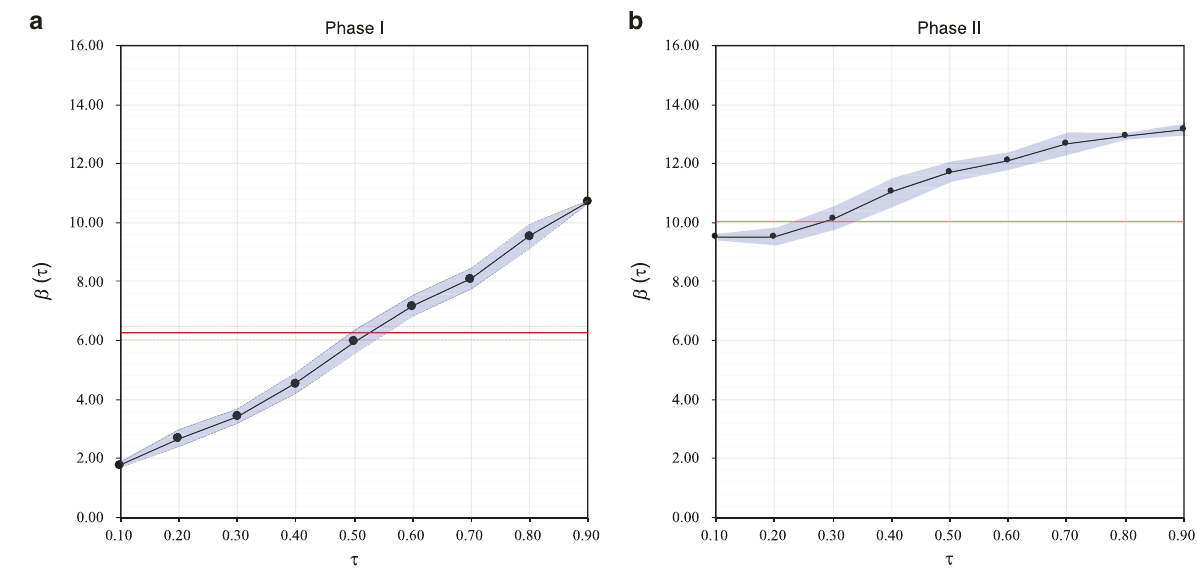
Fig. 2 The estimated results of the linear quantile regression model based on the of the fi rm-level trading data. In the plots of Phases I ( a ) and II ( b ), the estimated slopes of quantile 0.1 to 0.9 are plotted as a function of β ( τ ), the estimated intercepts of the results are not reported for simplicity and speci fi city reasons. The area enclosed by gray dotted lines represents a 95% con fi dence interval of estimated β ( τ ). The red line indicates the overall linear coef fi cient and its 95% con fi dence interval is enclosed by red dotted lines.